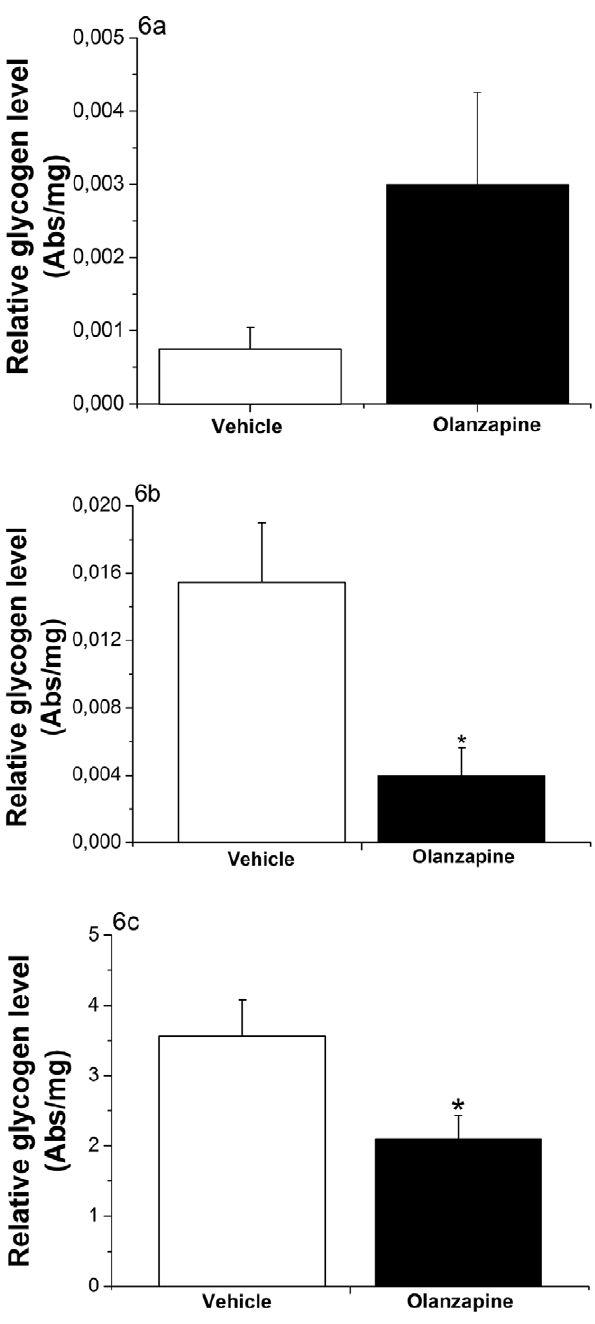
Figure 6. Effects of intragastric infusion of Olanzapine on liver glycogen content in Experiments 1, 2 and 3. 6a: During Experiment-1 hepatic glycogen levels show a non-significant increase in the Olanzapine-treated animals (p=0.096; T-test). 6b: During the low- level hyperinsulinemic-euglycemic clamp (Experiment-2) hepatic glyco- gen levels are decreased in the Olanzapine-treated animals (p=0.007; T- test). 6c: During the high-level hyperinsulinemic-euglycemic clamp (Experiment-3) the Olanzapine-treated animals show significantly less hepatic glycogen storage than the control group (p=0.043; T-test). Vehicle-treated animals = white bars; Olanzapine-treated animals = black bars. Abs/mg = Absorption measured at 600 nm per mg wet tissue.